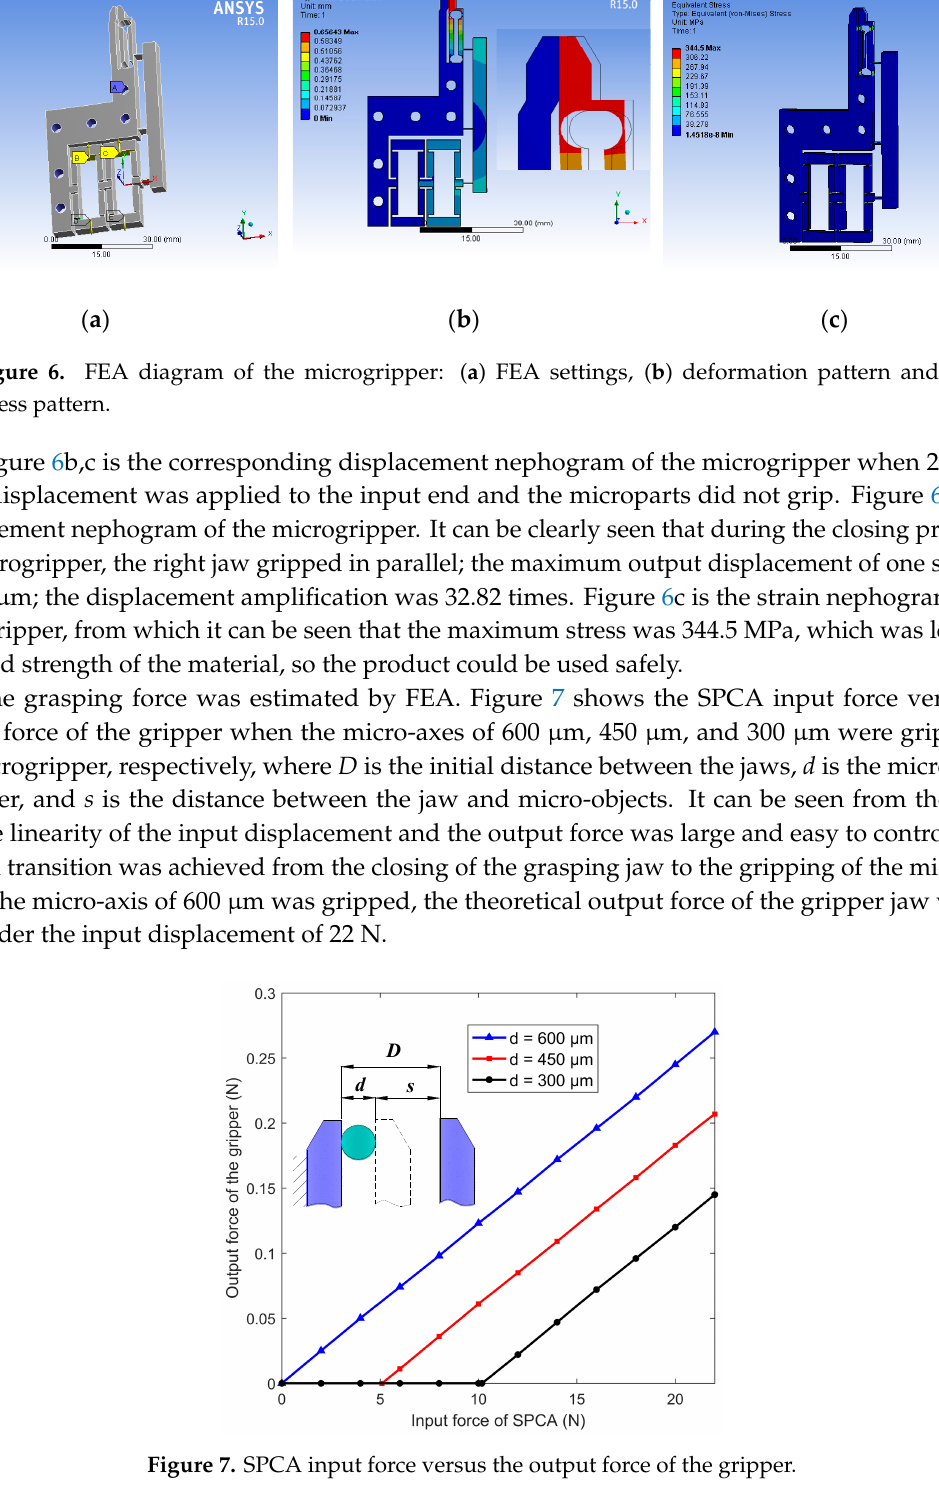
Figure 7. SPCA input force versus the output force of the gripper.